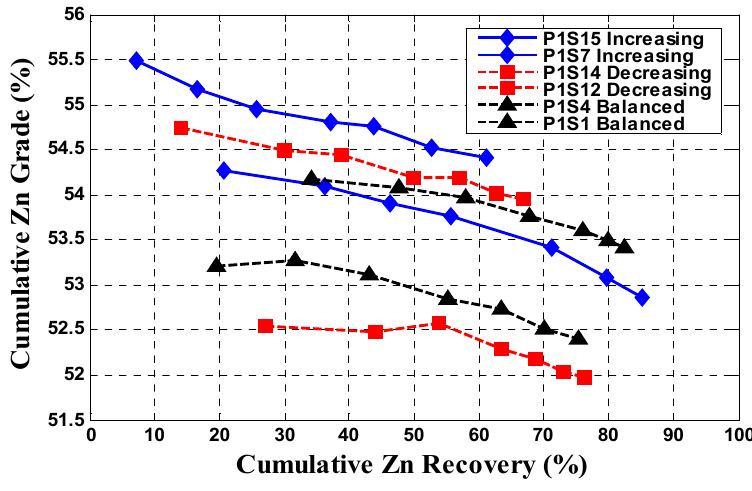
Figure 1. ‘Down-the-bank’ Zn grade-recovery curve showing best and worst performances of the three air rate profiles: increasing, balance and